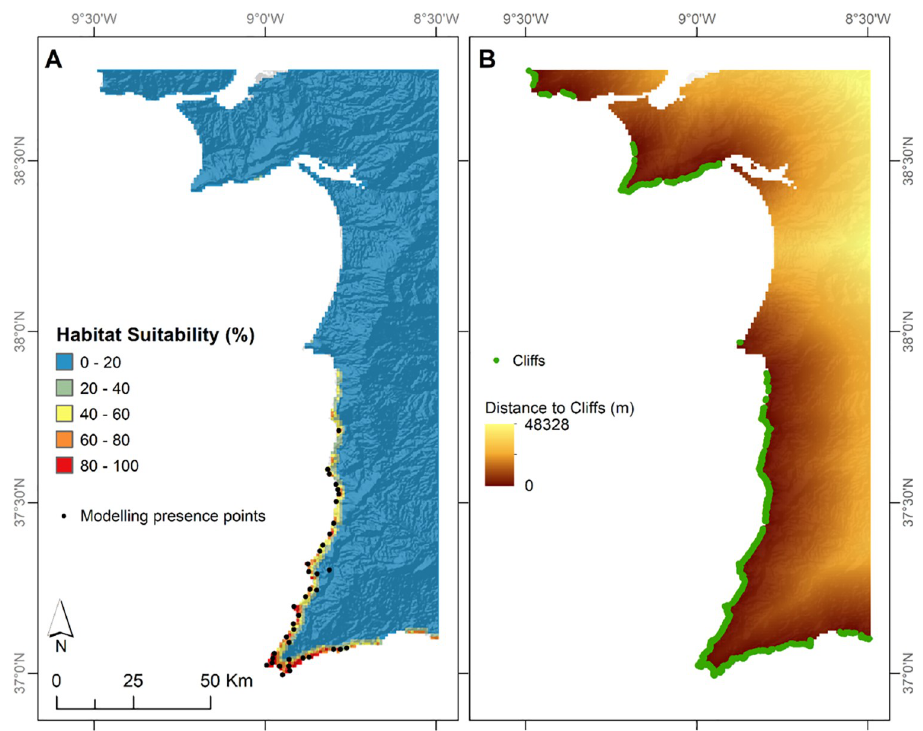
Fig 3. Habitat suitability map and coastal cliffs in the study area. (A) Current habitat suitability map and the 38 presence records used to produce it; (B) Identified cliffed coasts, and the distance between them and each location of the study area. This figure was assembled using ArcGIS Desktop v10.8.1 [26].